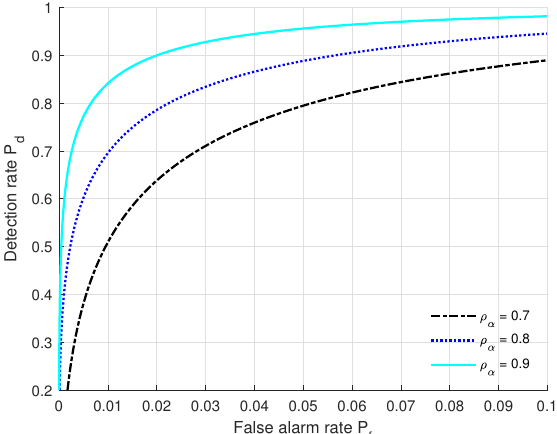
Figure 7. ROC curves under different correlation coefficients of path gain with the settings of (SNR = 10 dB, N r = 128, L = 20, k φ = 2 dB, k θ = 2 dB, k α = 2